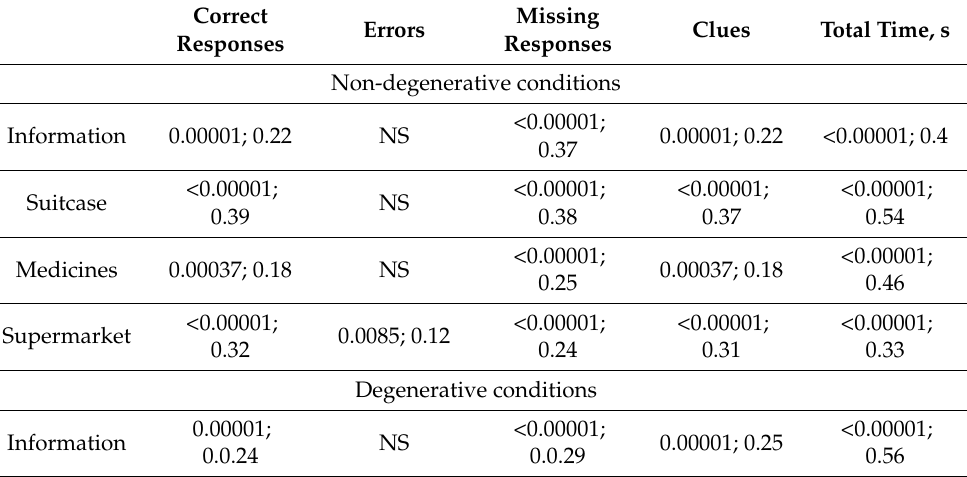
Table 3. Results obtained during the 10 VRT sessions from the EGs with both degenerative and non- degenerative conditions (Friedman test for repeated measures; all values are expressed as p -values; Kendall’s W coefficient of concordance